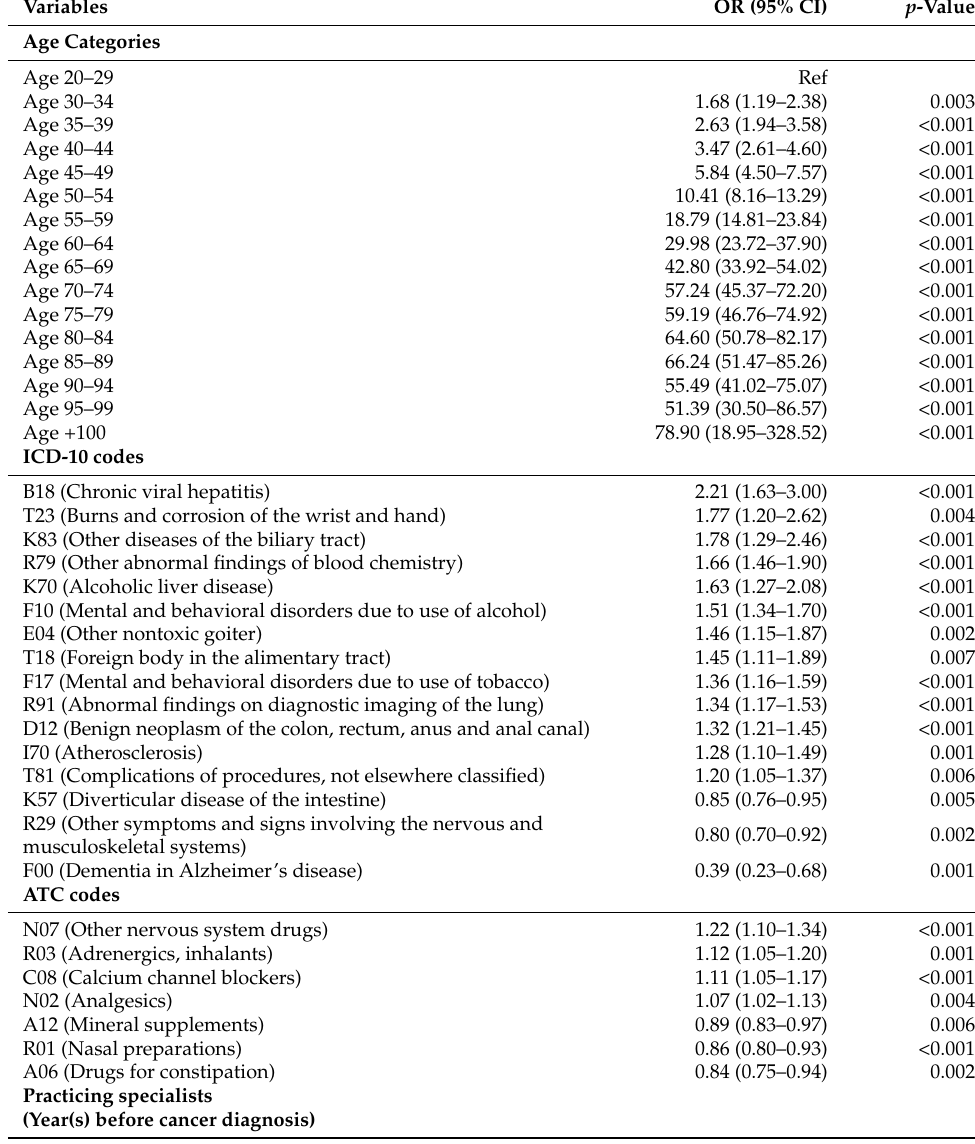
Table 3. Model A: Predictive risk factors in the development cohort with cancer as outcome: